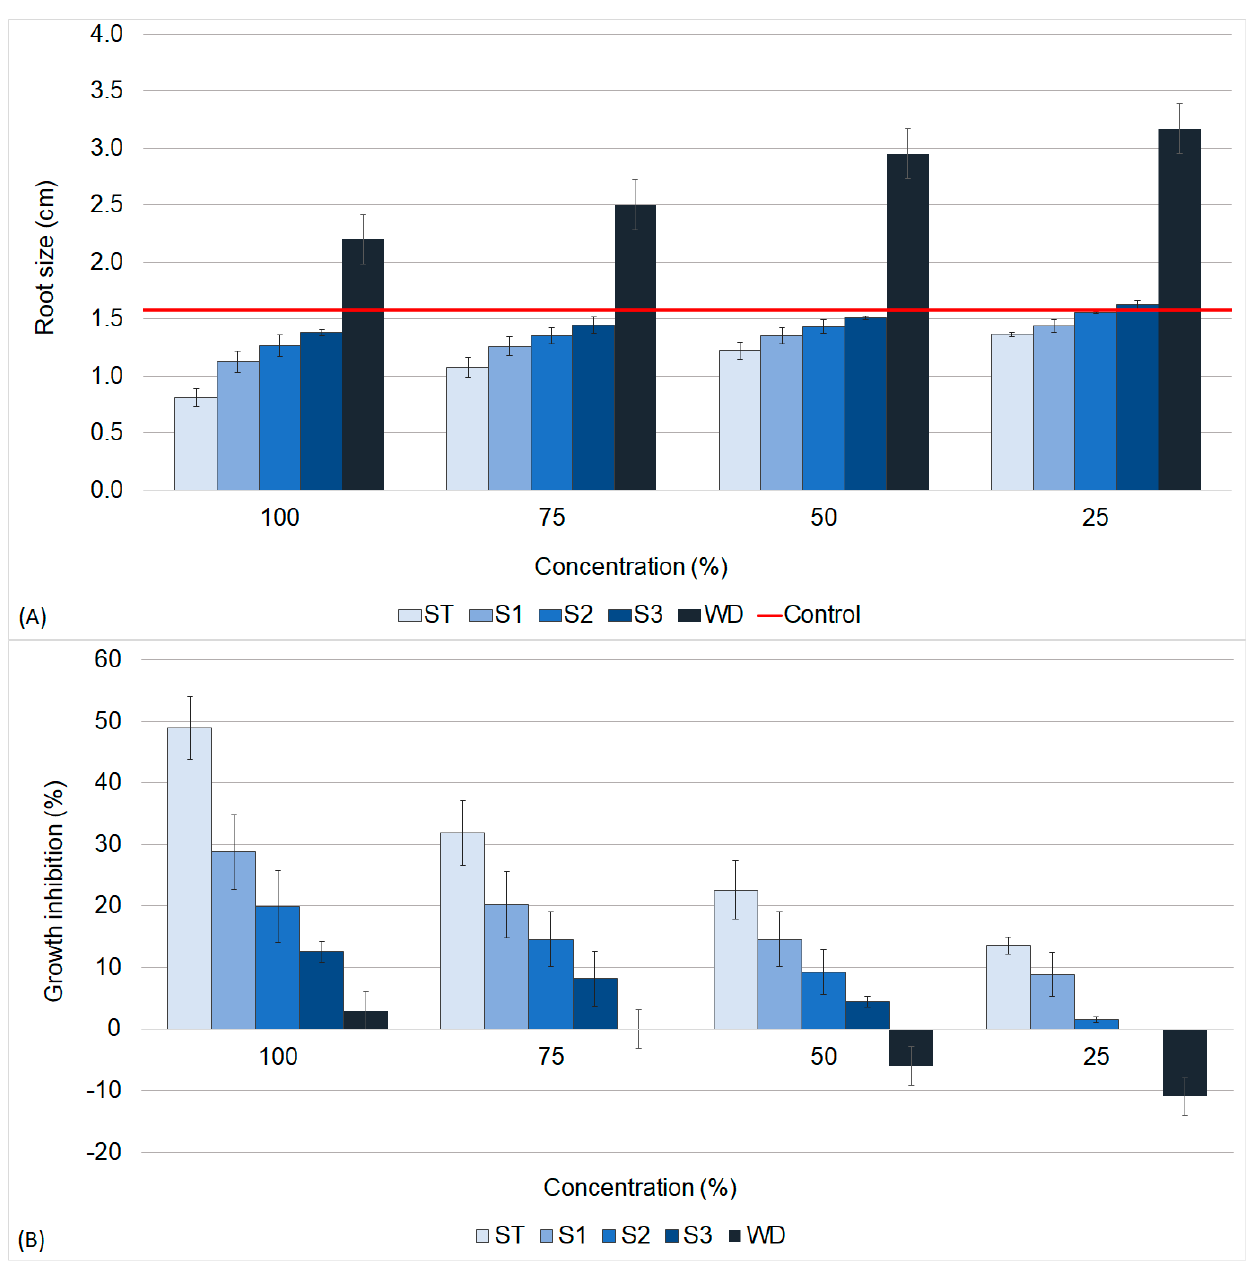
Figure 4. Root size ( A ) and growth inhibition ( B ) of Lactuca sativa seeds exposed to different evaluated samples. Abbreviations: wastewater without diclofenac (WD); post-septic tank domestic wastewater with diclofenac (ST); post-septic tank domestic wastewater with diclofenac, treated with solar radiation for 1 h (S1), 2 h (S2), and 3 h (S3). Diclofenac concentration of 100%: 30 mg·L − 1 ; 75%: 22.5 mg·L − 1 ; 50%: 15 mg·L − 1 ; 25%: 7.5 mg·L − 1 .